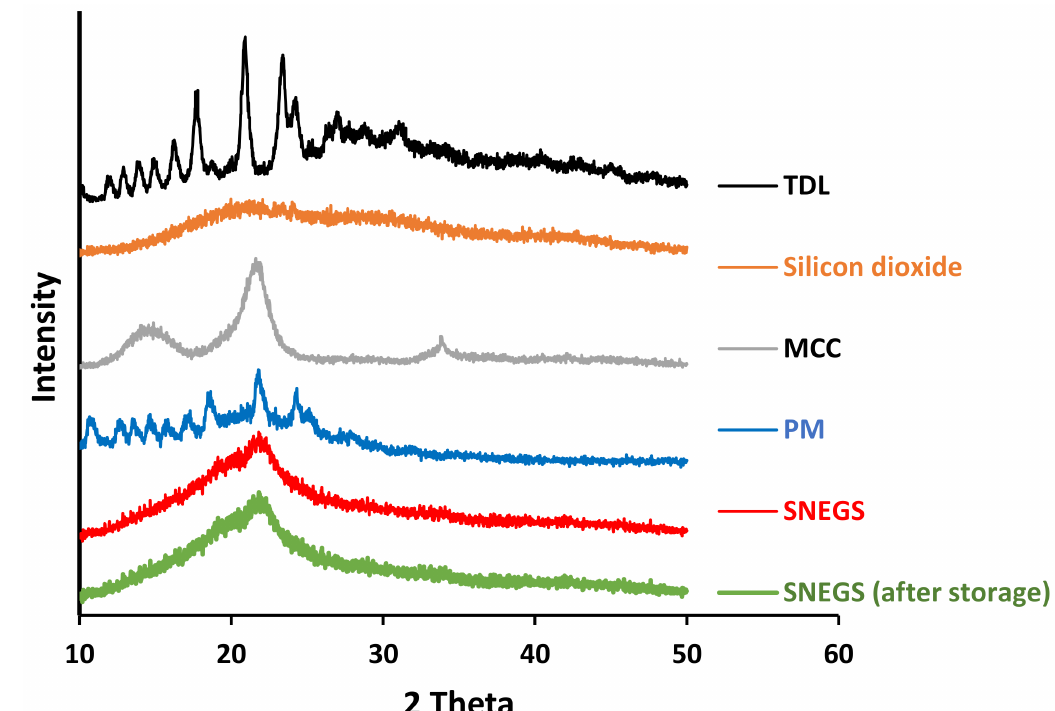
Figure 5. XRPD of tadalafil, silicon dioxide, MCC, physical mixture, and tadalafil-loaded self- nanoemulsifying granules (SNEGs).